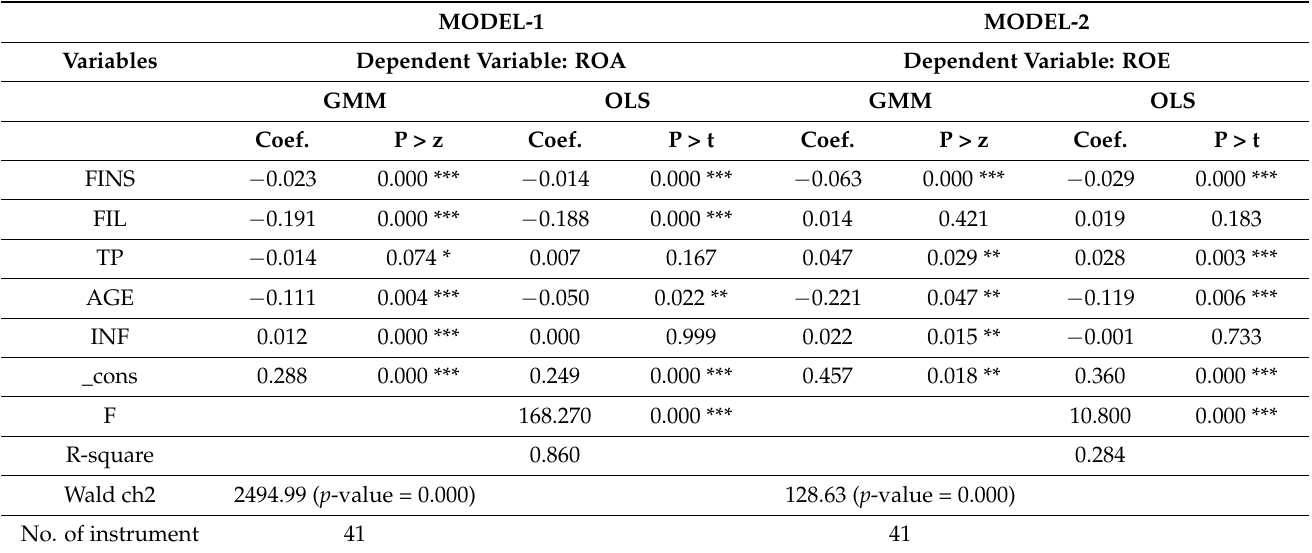
Table 9. Robustness check using GMM and OLS